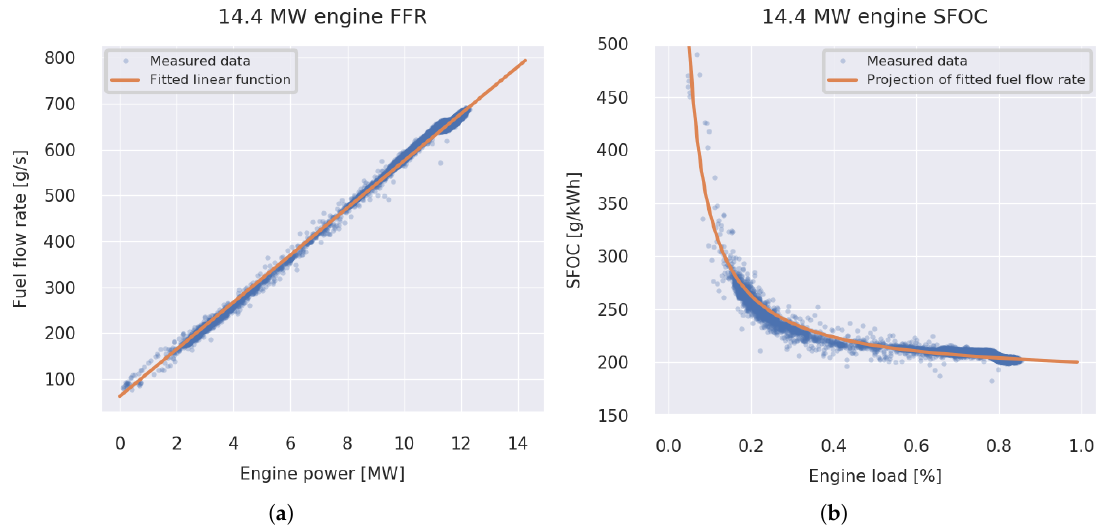
Figure 5. Large engine measured fuel flow rates and linear fuel flow rate curve fit ( a ) and linear fuel flow rate function projection on engine SFOC curve ( b